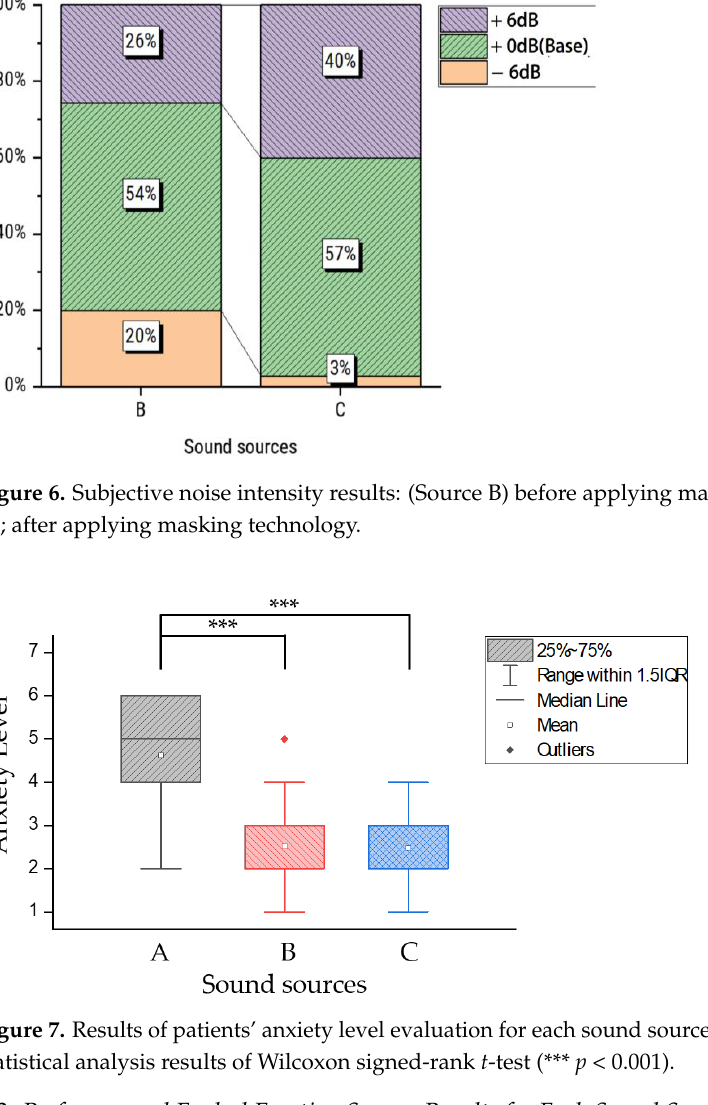
Figure 7. Results of patients’ anxiety level evaluation for each sound source (7-point Likert scale) and statistical analysis results of Wilcoxon signed-rank t-test (*** p < 0.001).